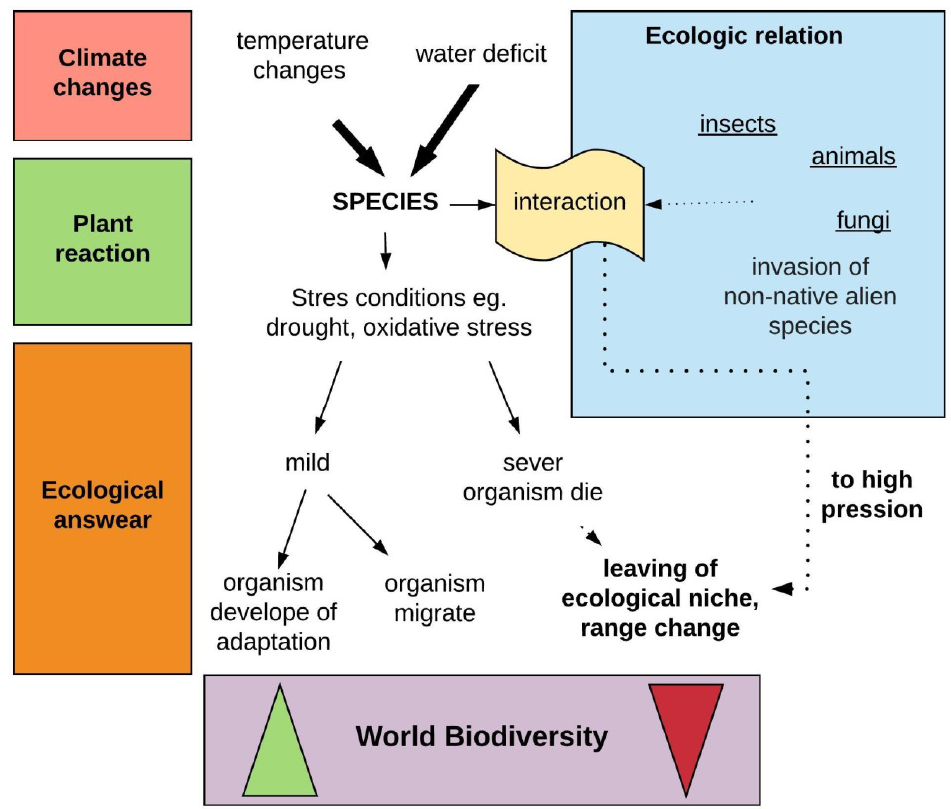
Figure 3. The relationship of climate change, plants’ reactions and ecological behavior to world biodiversity. Rapid changes in climate (e.g., temperature and water status) influence species, and plant physiology changes in response to stress conditions. If stress conditions are mild, the organism may develop adaptation and protect the range of the population (increase in biodiversity), or migrate (no changes in biodiversity but changes in the distribution of species); severe stress may lead to death of the organisms and, in perspective, to an ecological decrease in world biodiversity. In ecosystems, species. This interaction may aggravate stress, and when the pressure becomes too high, plant species be